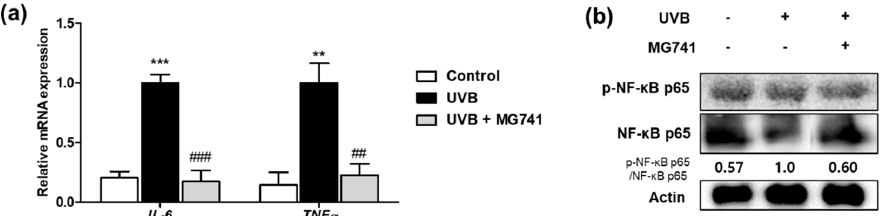
Figure 7. Effect of Bi. lactis MG741 on inflammation-related factors in UVB-exposed HR-1 mice. ( a ) The mRNA expressions of IL-6 and TNF α were measured by qRT-PCR. ( b ) The ratio of p-NF- κ B / NF- κ B was shown below the blotting images and indicated to fold of UVB-exposed control. Data are indicated as means ± SE ( n = 6). ** p < 0.01, and *** p < 0.001 vs. no-UVB control; ## p < 0.01, and ### p < 0.001 vs. UVB-exposed